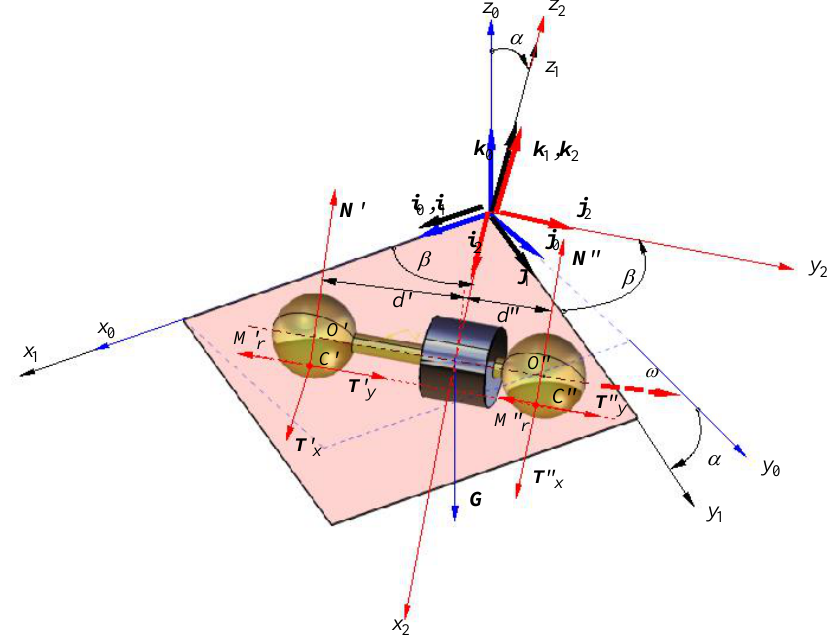
Figure 4. The rotor on the inclined plane and attached coordinate systems. The motion of the rotor under an angle with respect to the line of greatest slope of the plane (β) is equivalent to a rolling along the line of greatest slope for a plane with a much smaller angle of inclination, the angle that can be precisely determined by calculus.